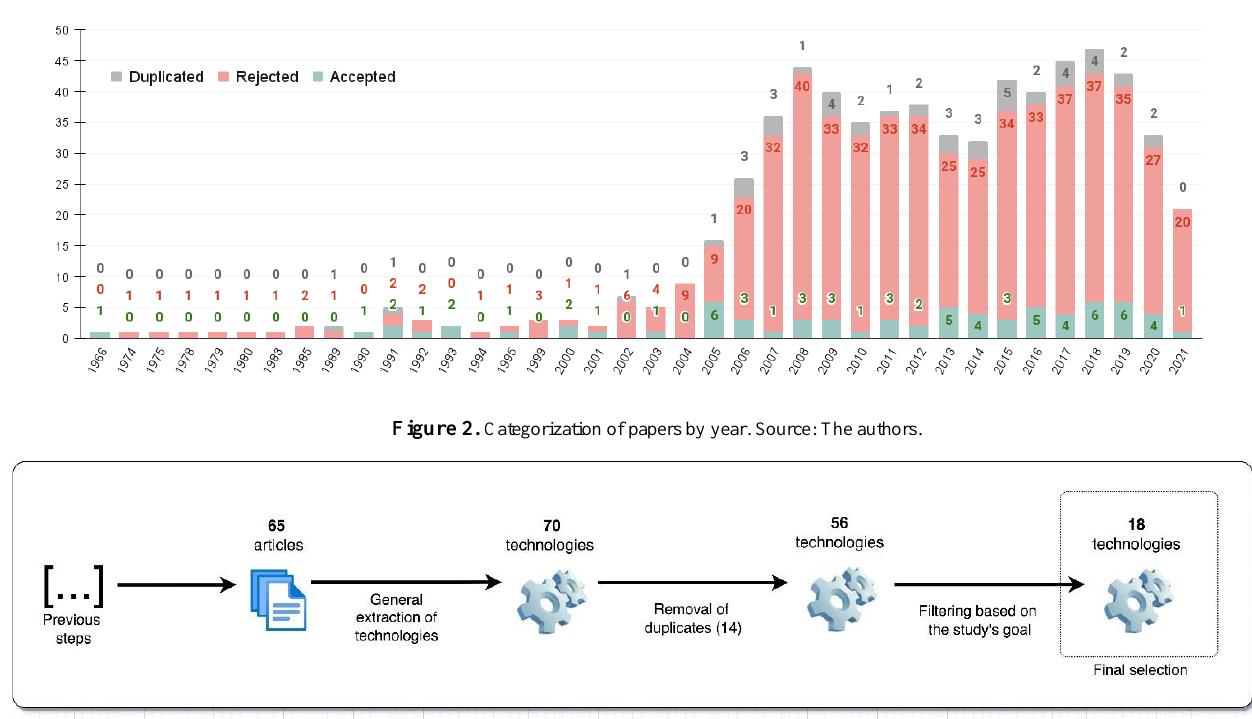
Figure 3. Identification and filtering of the technologies used from the articles selected. Source: The